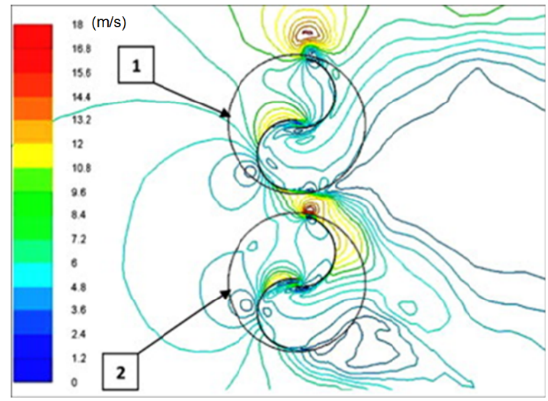
Figure 8. The two-rotor scheme and corresponding flow pattern [39].